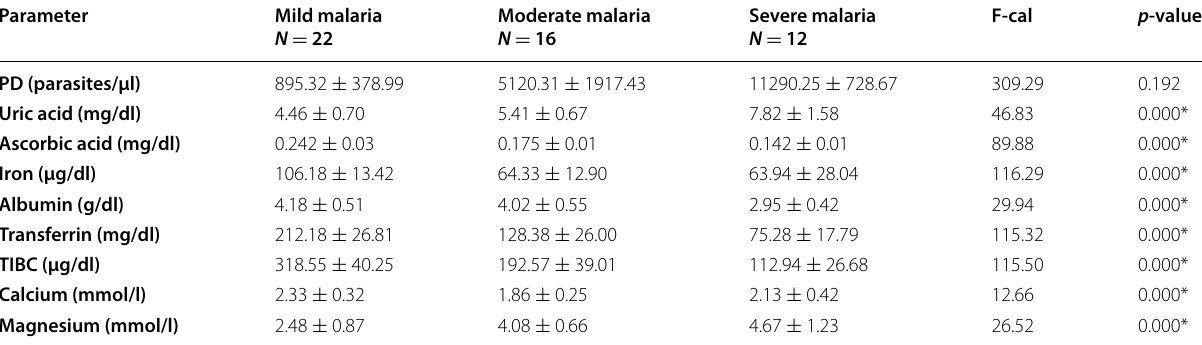
Values are expressed as mean SD. *Significant at P < 0.05, TIBC Total iron-binding capacity; PD Parasite density ±